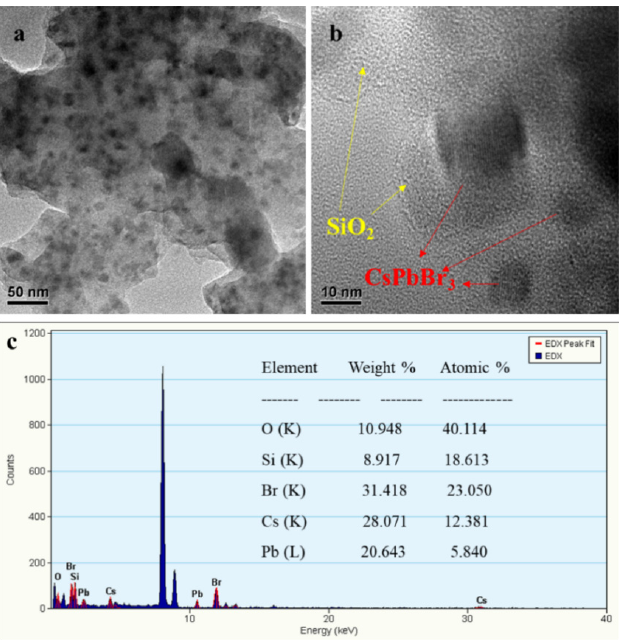
Figure 3. Morphology and chemical composition of CsPbBr 3 @SiO 2 PNCCs. ( a ) TEM images of CsPbBr 3 @SiO 2 PNCCs; ( b ) HRTEM image of CsPbBr 3 @SiO 2 PNCCs. ( c ) EDX analysis of CsPbBr 3 @SiO 2 PNCCs.